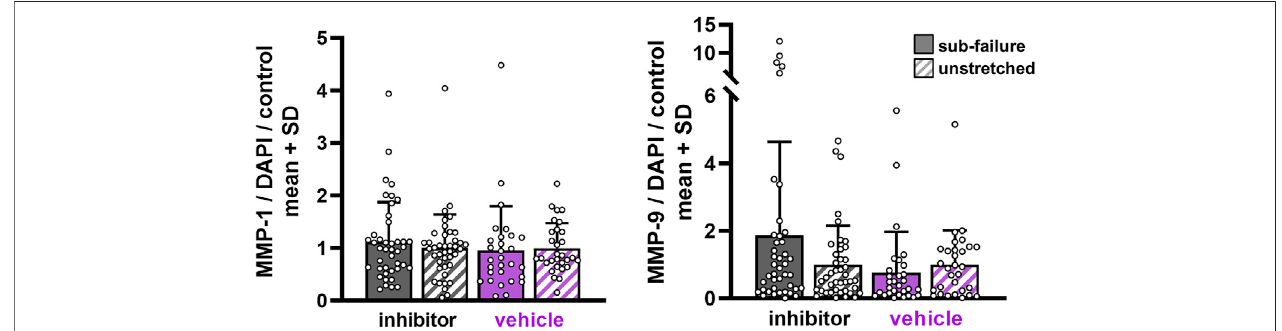
FIGURE 7 | MMP expression with sub-failure equibiaxial stretch is unchanged regardless of ilomastat or vehicle treatment. Separate MANOVA analyses between sub-failure and unstretched gels in the inhibitor ( p = 0.114; MANOVA n = 7/stretch condition) and vehicle ( p = 0.165; MANOVA, n = 5/stretch condition) groups reveal similar expression levels. Superimposed data points represent quanti fi cation in each confocal image acquired ( n =